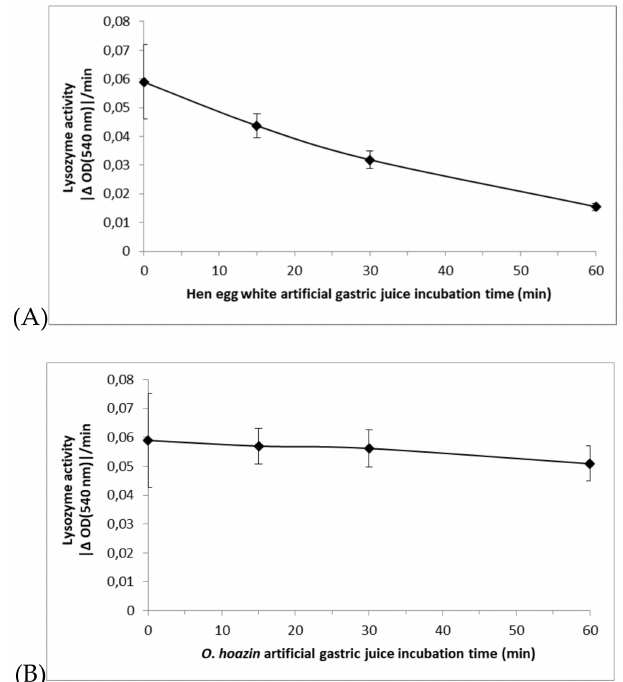
Figure 9. Activity of ( A ) HEWL and ( B ) Oh Lys measured by the turbidity assay after incubation, as described above under “In vitro stability of OhLys vs. HEWL under gastric conditions”. Oh Lys retains a high level of activity after one hour (close to 100%), while that of HEWL has dropped substantially. These results refer to WT Oh